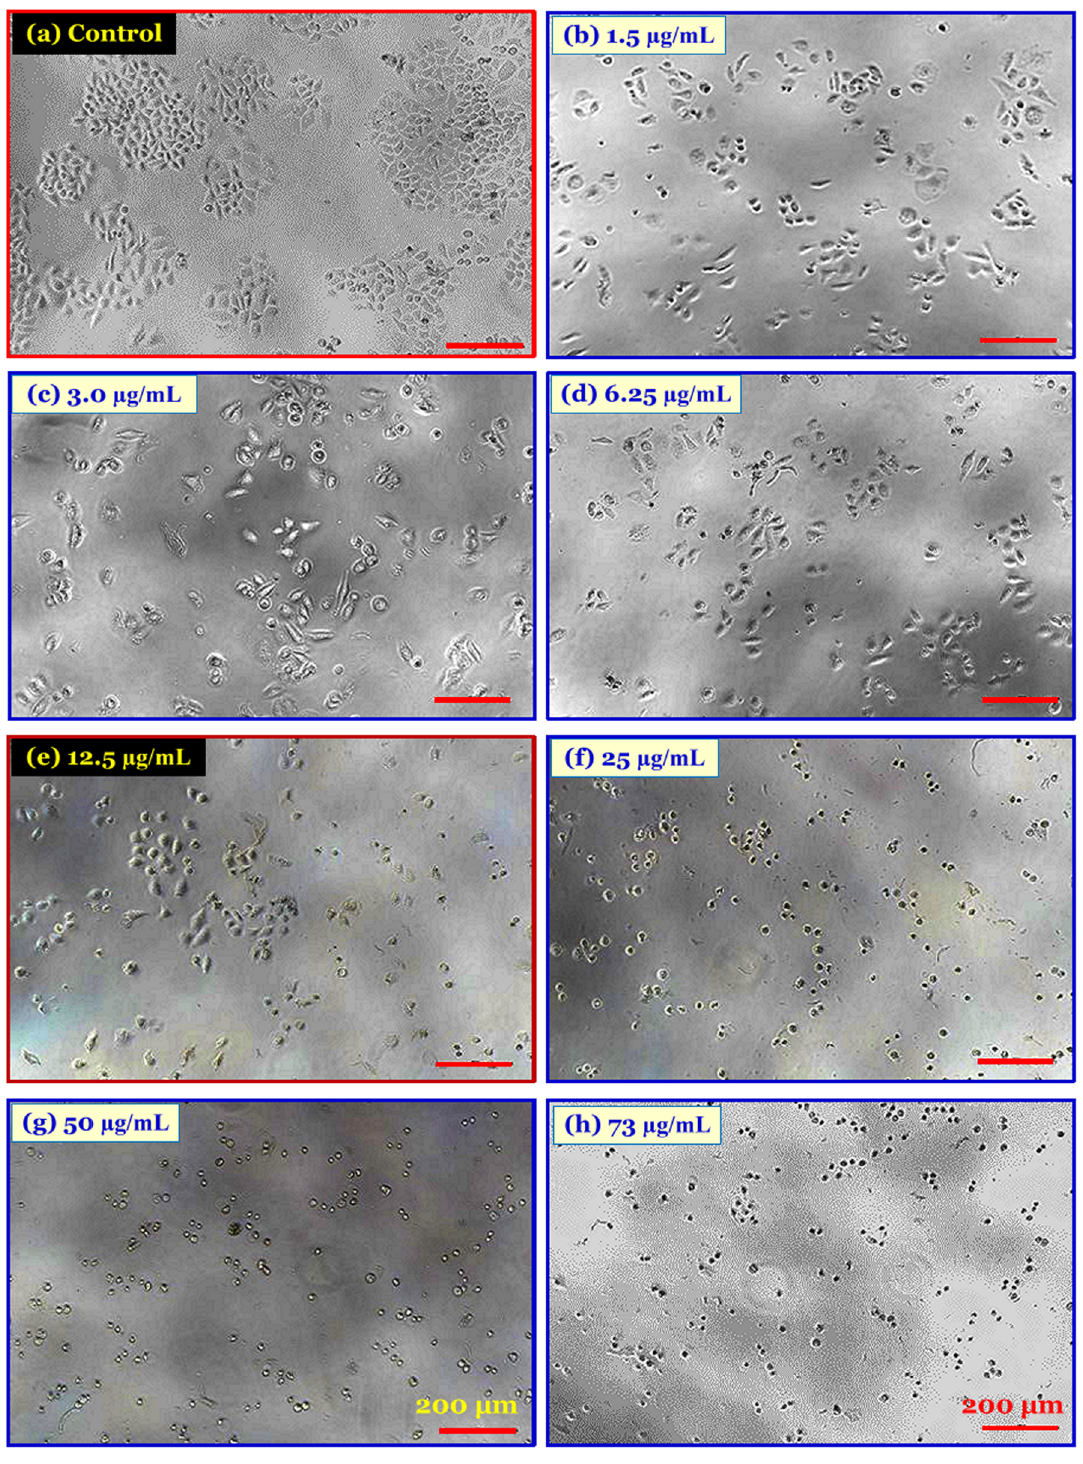
Figure A3: Cell growth inhibition assays of C. Hindsii - AuNPs on HeLa